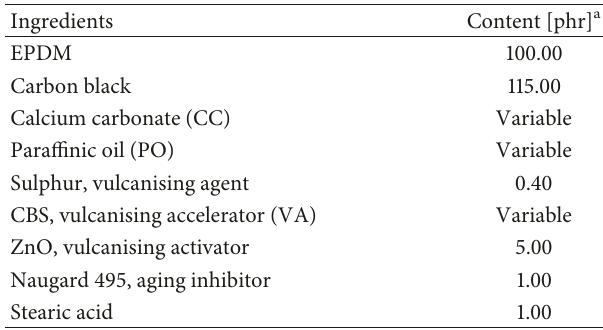
Table 1: Base composition of industrial EPDM rubber